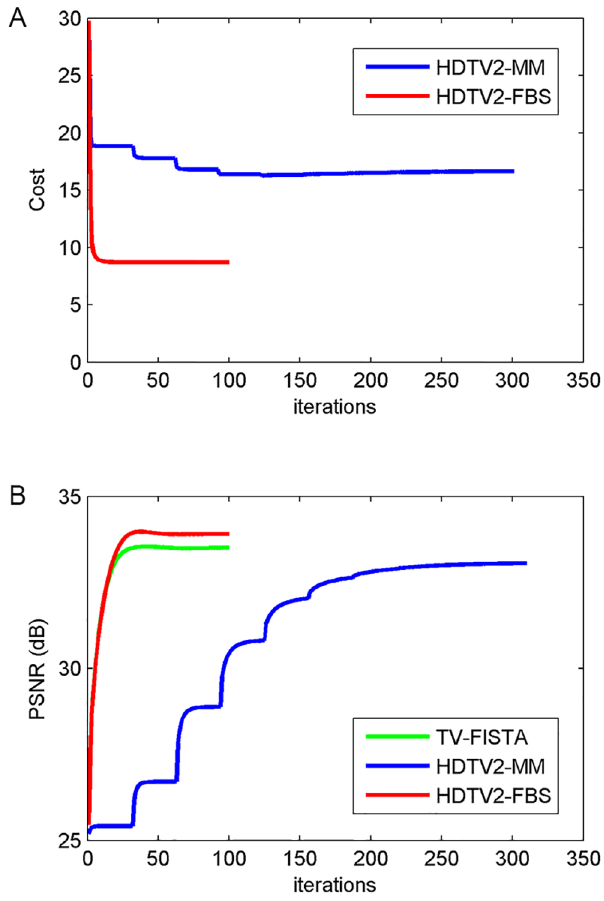
Fig 2. The convergence curve of the cost of objective function and PSNR results versus iterations corresponding to the reconstructed example shown in Fig 1. (A) Cost versus iterations; (B) PSNR versus iterations.